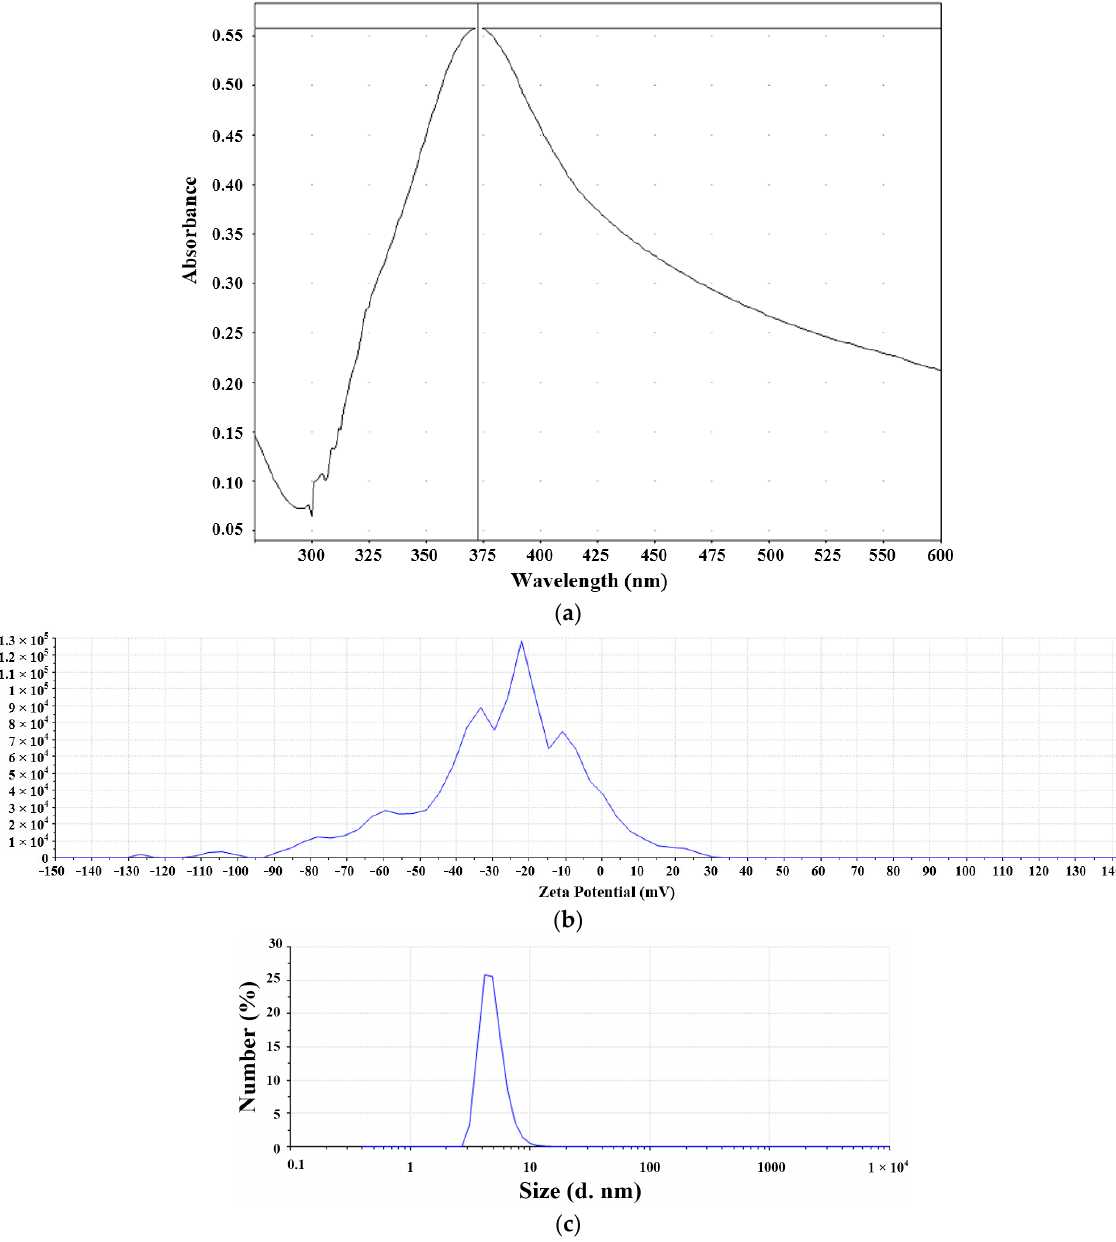
Figure 8. Characteristics of nanosilver colloid prepared using micro-EDM: ( a ) UV absorption wave- length; ( b ) zeta potential; ( c ) number PSD.